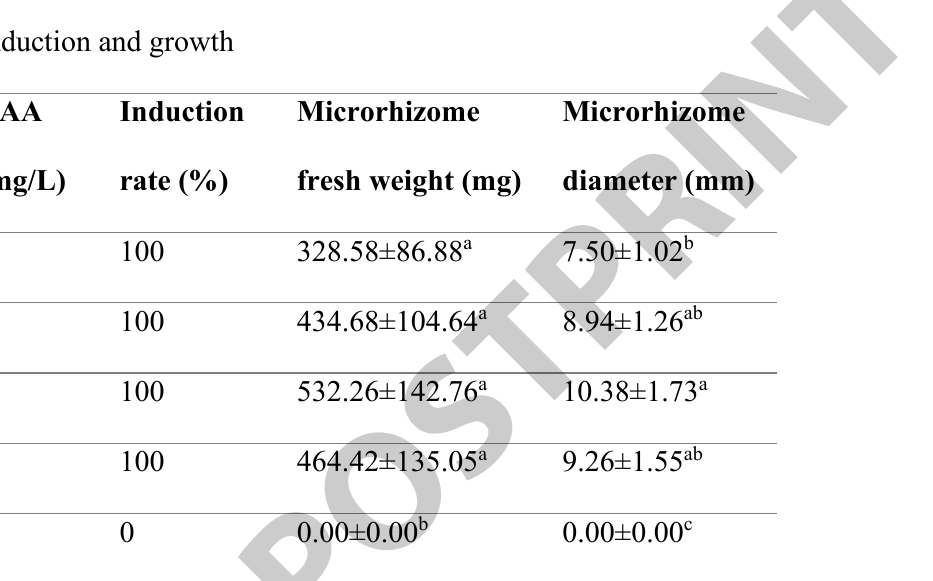
Table 5. Impact of different indole-3-butyric acid (IBA) concentrations on microrhizome induction and growth